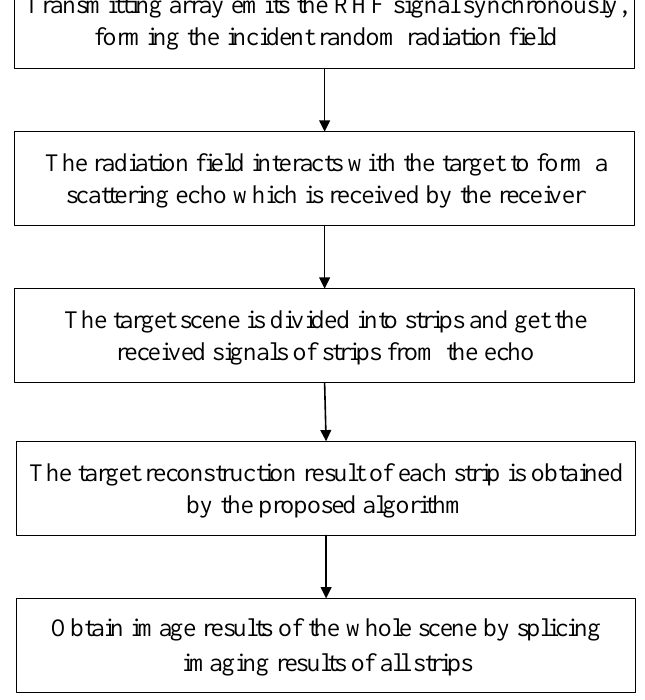
Figure 2. Imaging process flow